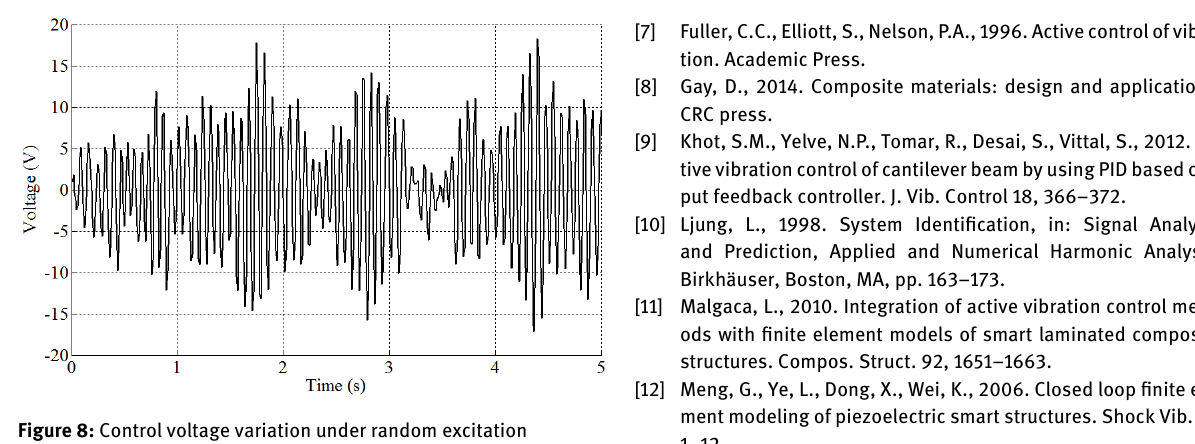
coupled with system identification technique to obtain the state space equation. LQG control law is designed and im- plemented into APDL to calculate the voltage gain. Numer- ical results demonstrate that the control algorithm is effi- cientinreducingthevibrationwhichencouragesusingthe presented technique for more complex